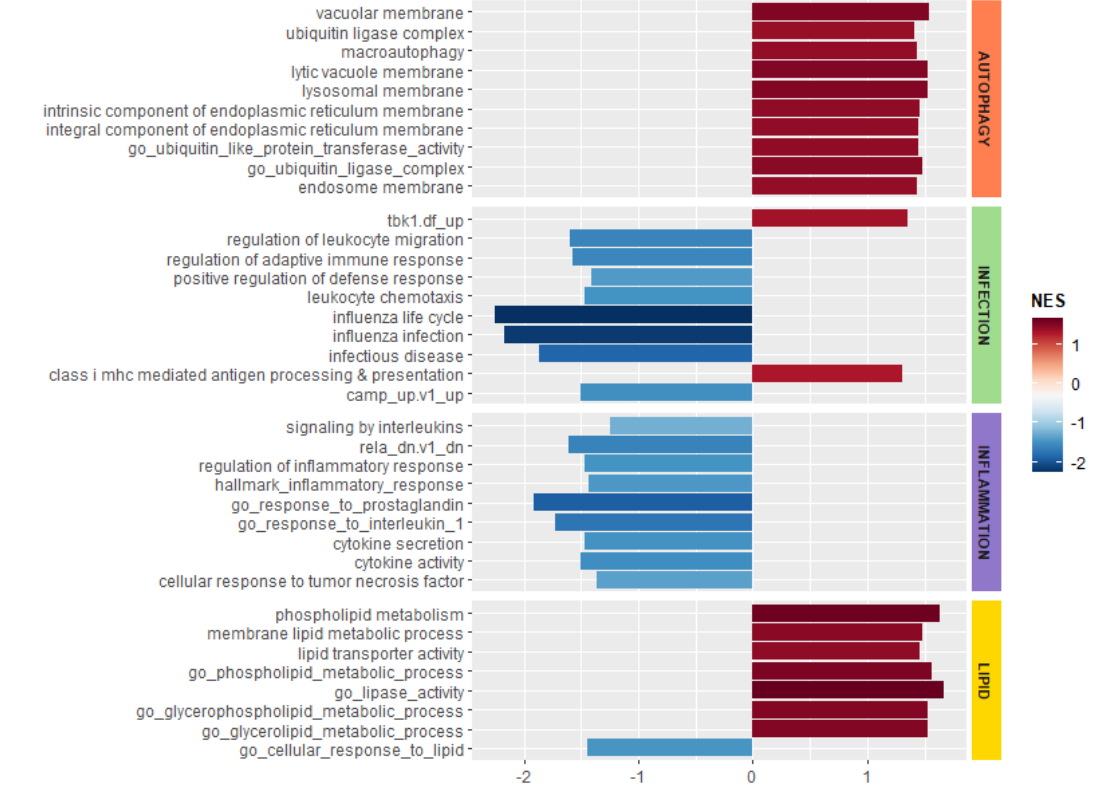
Figure 6. Enriched gene set enrichment analysis (GSEA) terms—functional categories. This chart shows the results of GSEA analysis on functional categories related to CF pathology using pre-ranked logFC list genes from MyrAsp / Asp CF analysis. In red, the terms with positive normalized enriched score (NES), upregulated by myriocin, whereas in blue the terms with negative NES, downregulated by myriocin. GSEA terms include GO, MutSigDB, and KEGG pathway terms.